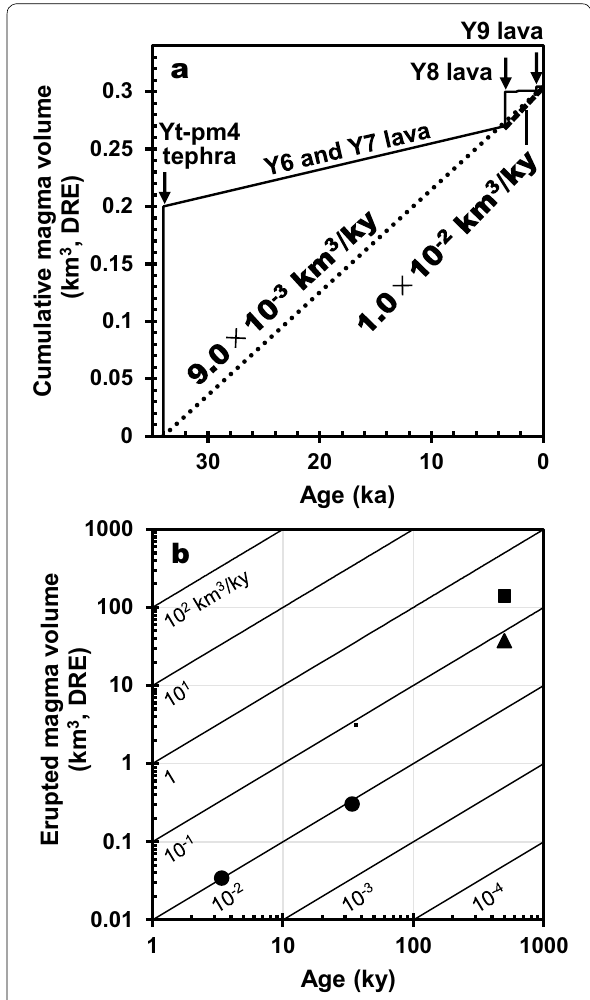
Fig. 8 a Cumulative magma volume derived from Yokodake volcano. Dotted and dashed lines, respectively, indicate the eruption rate at 34 ky and 3.4 ky. b Estimated magma eruption rate of Yokodake volcano, northern Yatsugatake, and all Yatsugatake volcanoes obtained using our data and earlier results (Kawachi et al. 1978; Oishi and Suzuki 2004; Okuno and Kobayashi 2010; Nishiki et al. 2011; Oishi 2015). Circles represent the eruption rate of Yokodake during the past 34 ky and 3.4 ky. The triangle and square, respectively, represent the eruption rates of northern Yatsugatake and Yatsugatake volcanoes during a 0.5-My